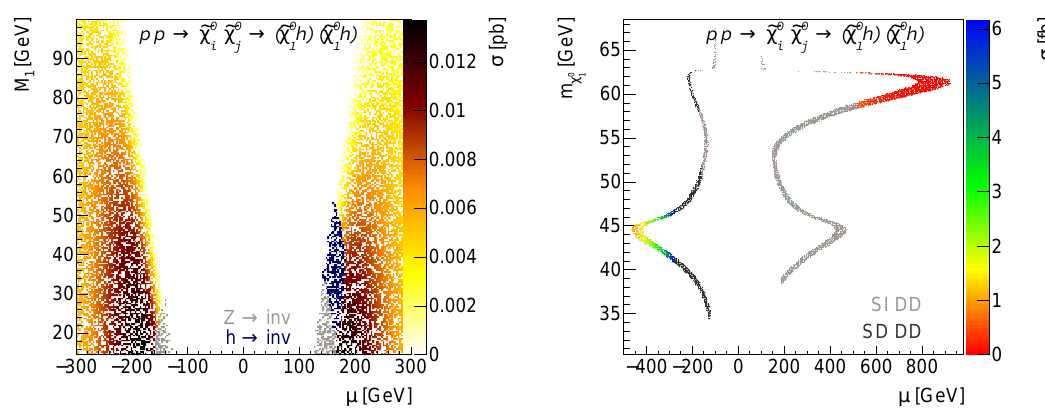
Figure 15: Cross section for the mono-Higgs-pair process in the µ − M points fulfilling the chargino mass bound, shown with the limits on invisible Z and Higgs decays. Right: points also predicting the correct relic density, shown with DD